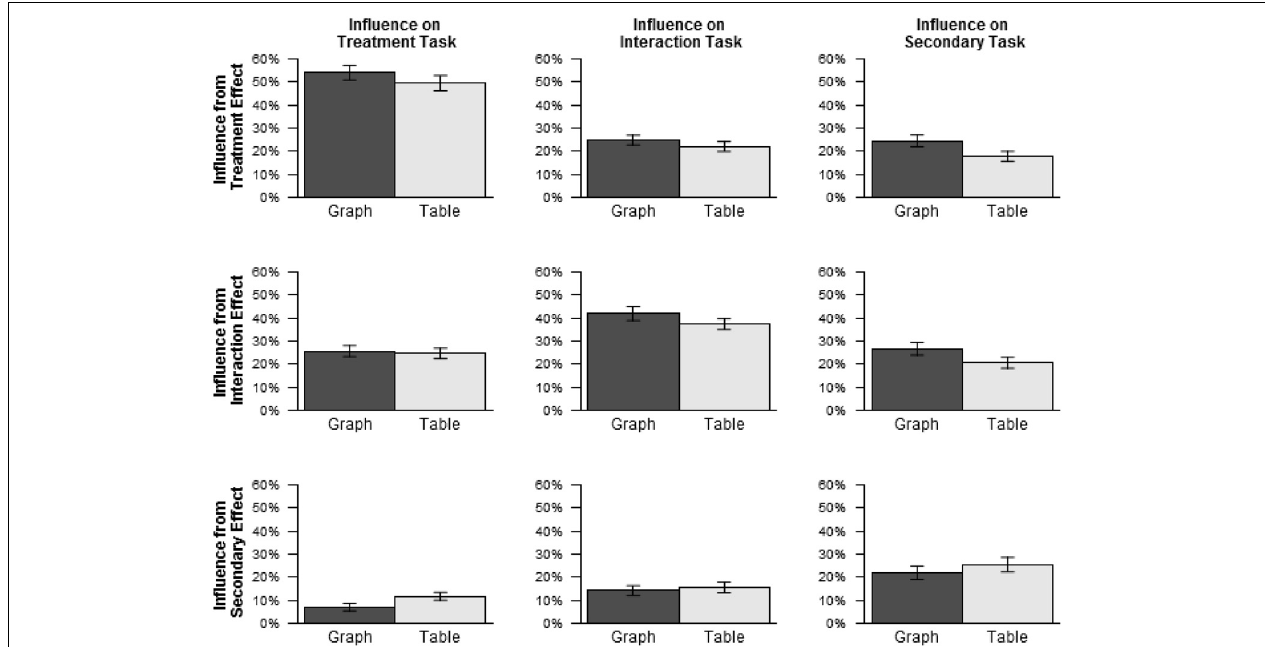
FIGURE 4 | Influence by influencing effect and influenced task for graphs and tables (Experiment 1).